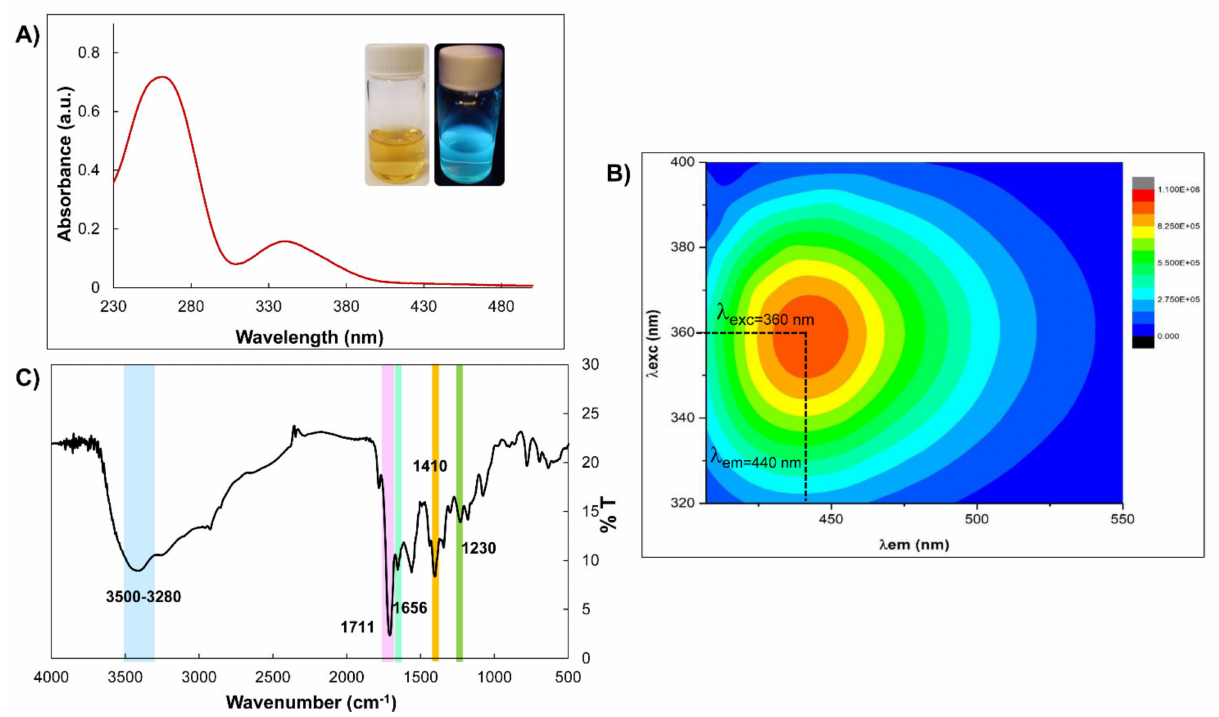
Figure 2. ( A ) Absorption spectra of CDs (inset: CDs under white (left) and UV light (right)), ( B ) 2D-contour diagram of excitation/emission spectra of CDs, and ( C ) FT − IR spectrum of